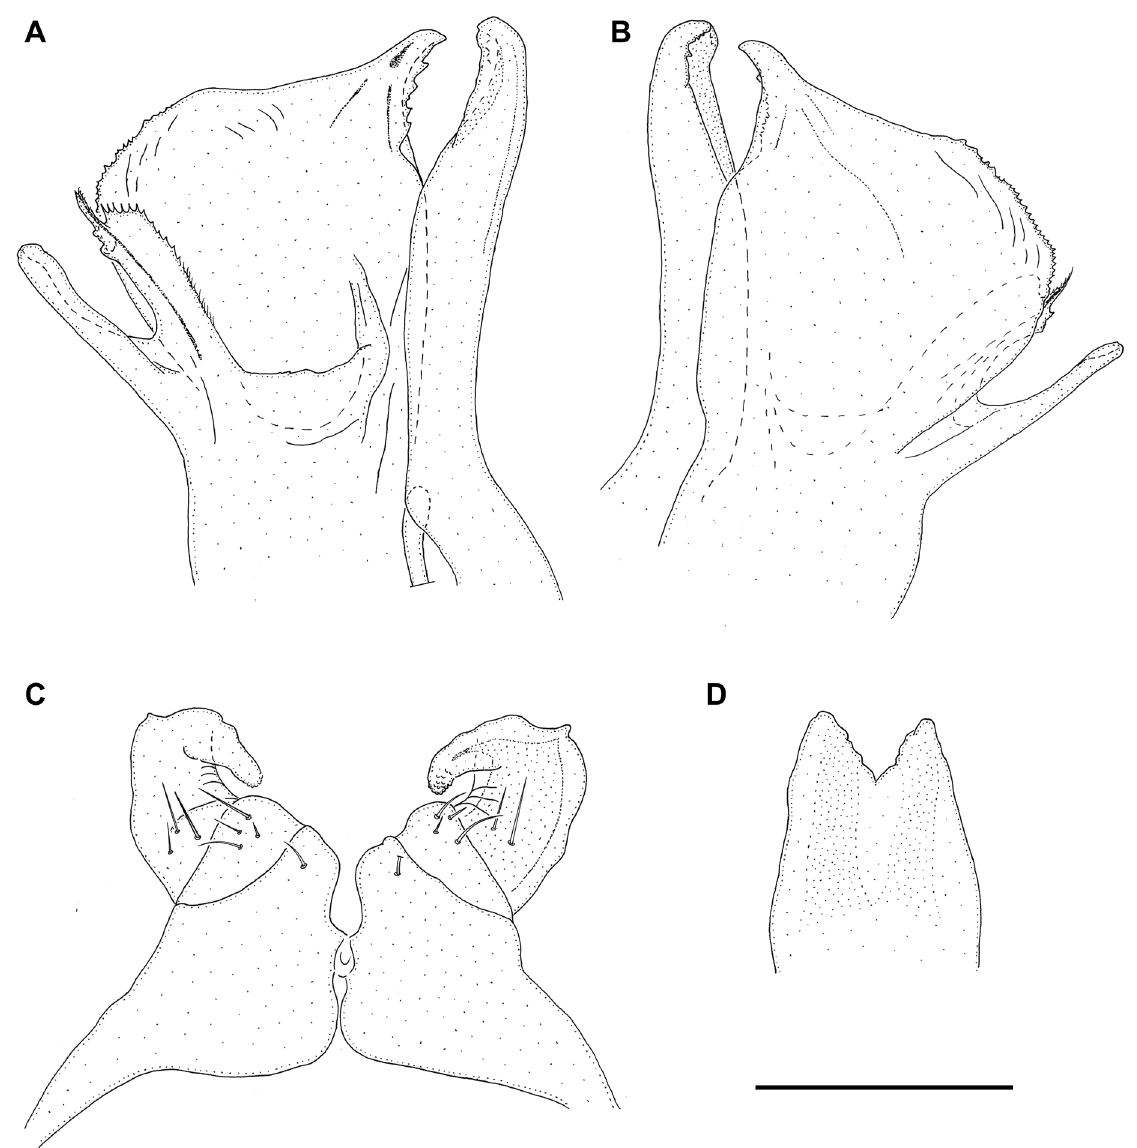
Fig. 41. Leucogeorgia mystax sp. nov., holotype ♂ from Nytshka Cave (ZMUM). A . Right gonopods, mesal view. B . Right gonopods, lateral view. C . Leg-pair 1, anterior view. D . Penes, posterior view. Scale bar: 0.2